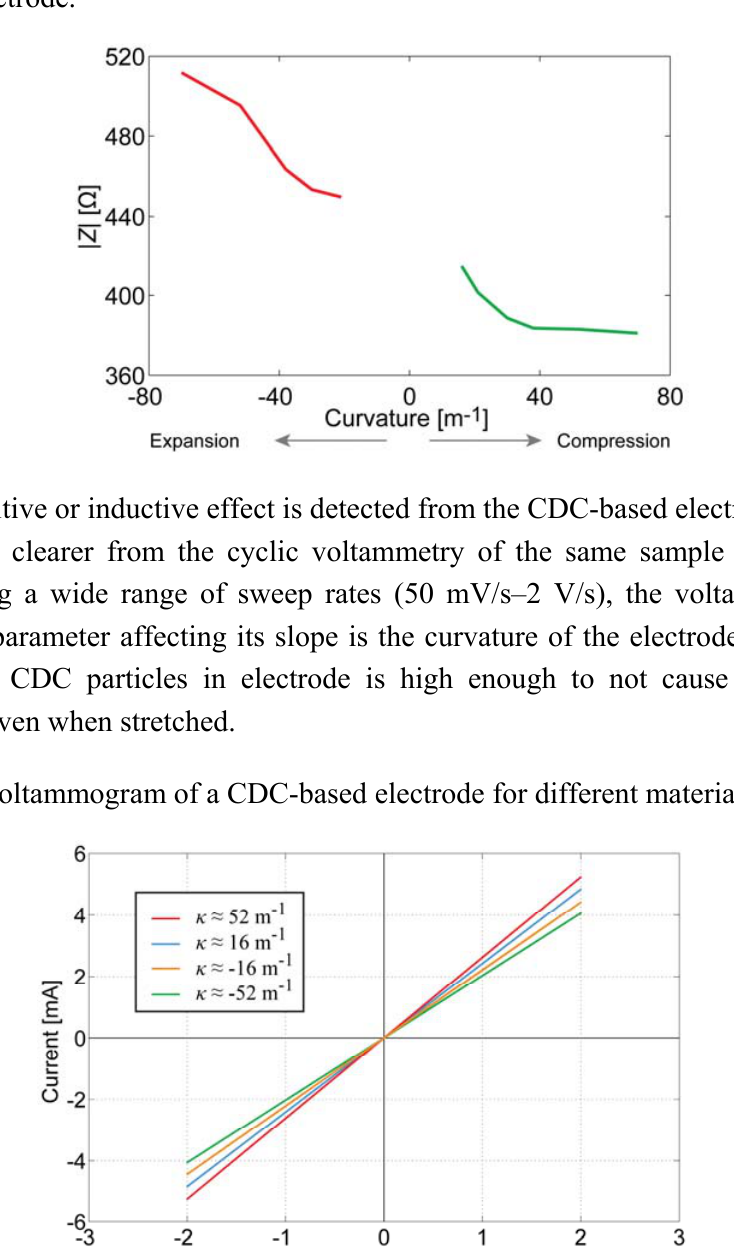
Figure 12. The correlation between the curvature and the impedance modulus of a CDC-based electrode.